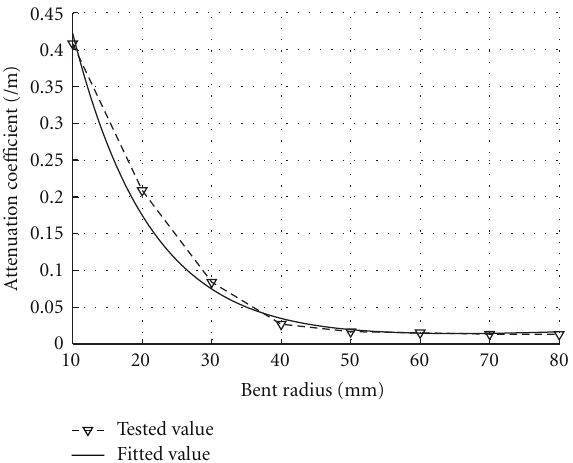
Figure 8: Di ff erence between attenuation coe ffi cient in air and liquid.